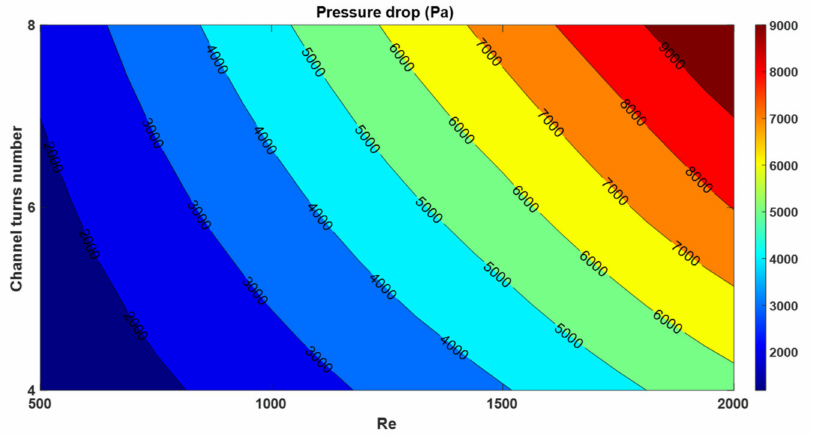
Figure 9. Variations in pressure drop at different Reynolds numbers for channel turns numbers of 4, 6, and 8 for a cooling system using water as the coolant—results were obtained from 12 simulations.